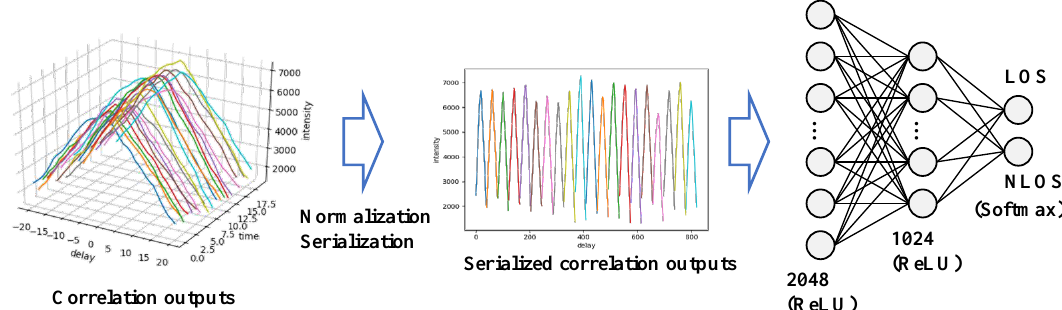
Figure 6. Overview of the proposed NLOS detection system using a neural network (NN). Serialized correlation outputs are input to a fully connected layer of the NN. Here, ReLU is an activation function, and the softmax is a function that outputs the probability. The probability of the LOS and NLOS signals is output of the